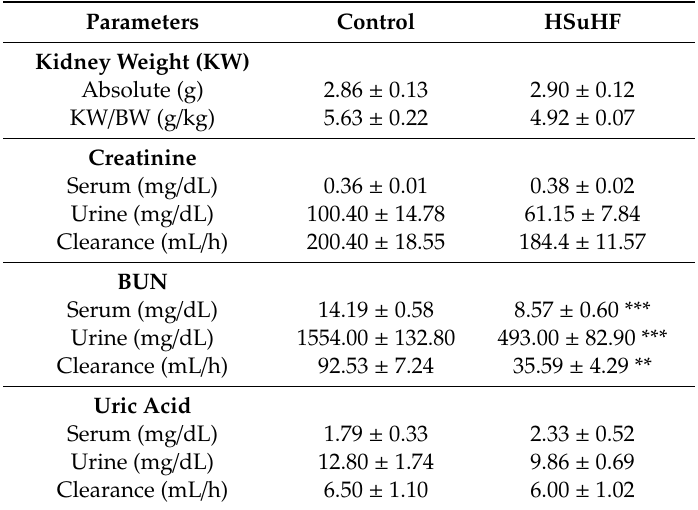
Table 4. Kidney weight and serum and urine measures of renal